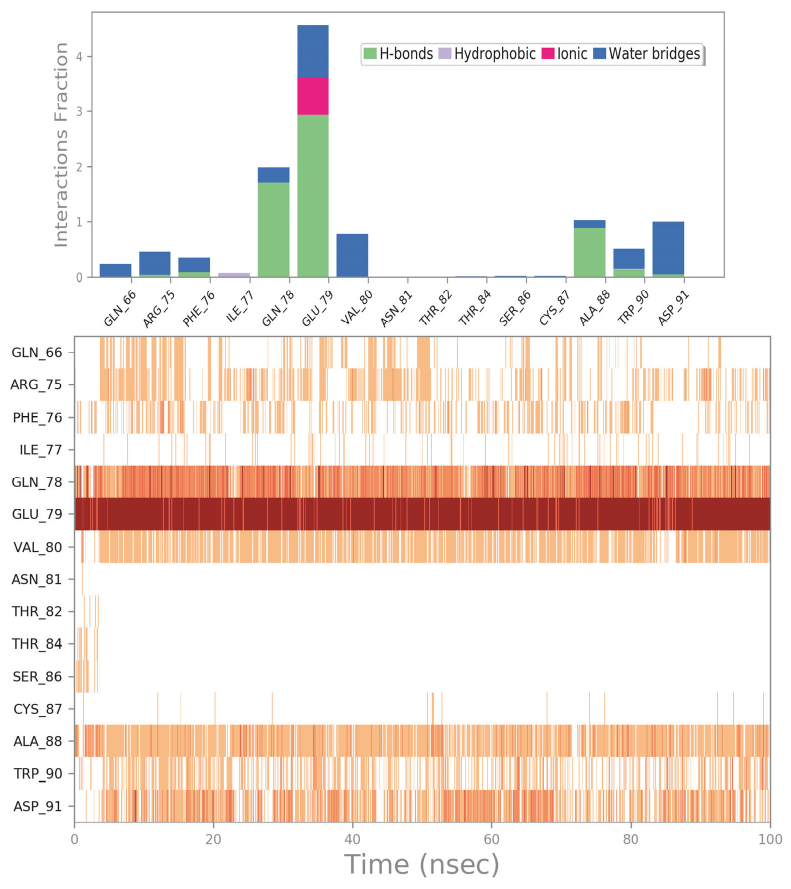
Figure 6. ZINC000060183170 monitored during the MD run. The interactions can be grouped into four types: H bonds (green), hydrophobic (grey), ionic (magenta), and water bridges (blue). The subsequent diagram of the figure illustrates a timeline description of the main interactions. A darker hue of orange indicates that some residues make many distinct contacts with the ligand (Maestro, Schrödinger LLC, release 2020-3).